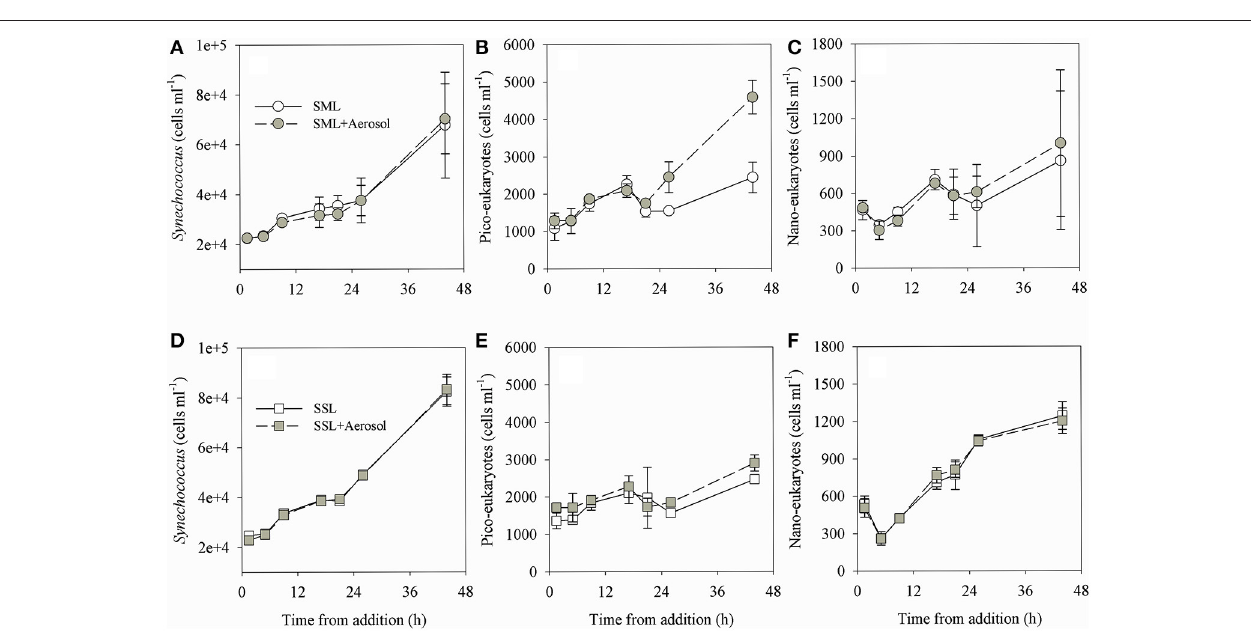
FIGURE 1 | The temporal dynamics of Synechococcus (A,D) , pico-eukaryotes (B,E) and nano-eukaryotes (C,F) in the SML (top panels) and SSL (bottom panels) microcosms. Experiments including aerosol additions (1.5mg L − 1 ) are presented in gray, control experiments (containing no additions) are colored white. Values are the averages and standard deviation from 3 biological replicates ( n = 3).